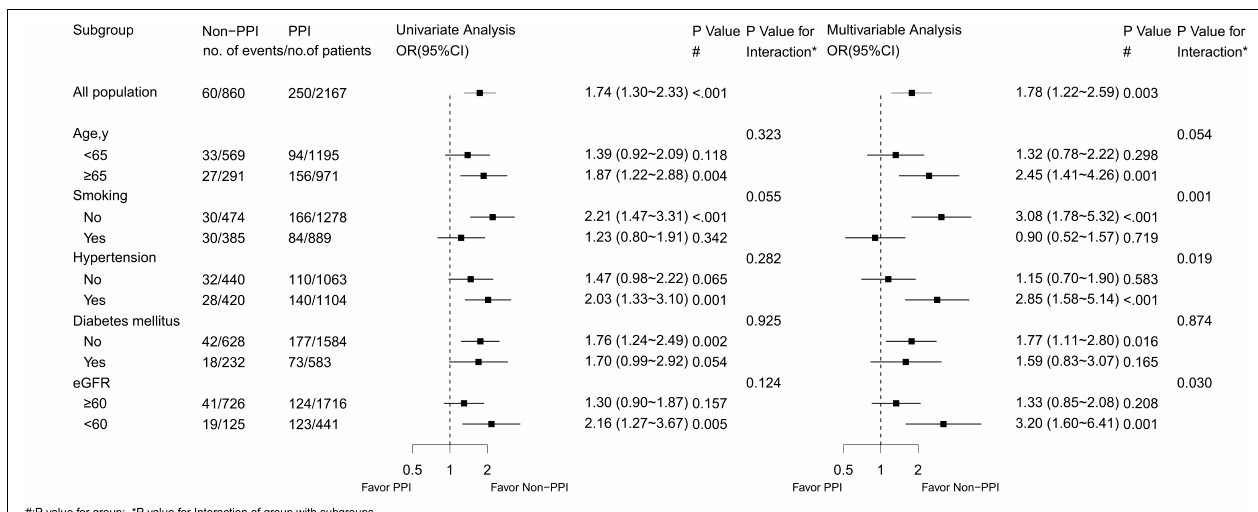
FIGURE 3 | Subgroup analysis of